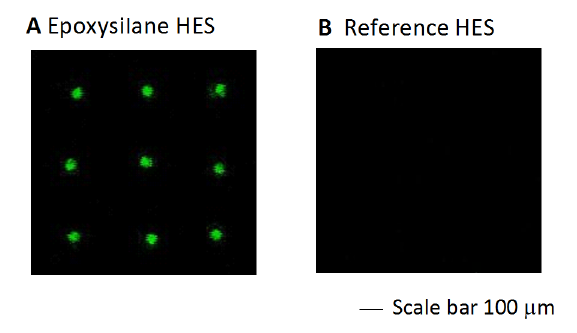
Figure 2: Ability of the epoxysilane-HES to immobilize peptides: fluo- rescence measurement (60% power laser and gain) are relative to Cy3-labelled A β 40 peptides spotted on (A) an epoxysilane and (B) on an O 2 -plasma treated HES after the extensive washing involved in the BSA-blocking